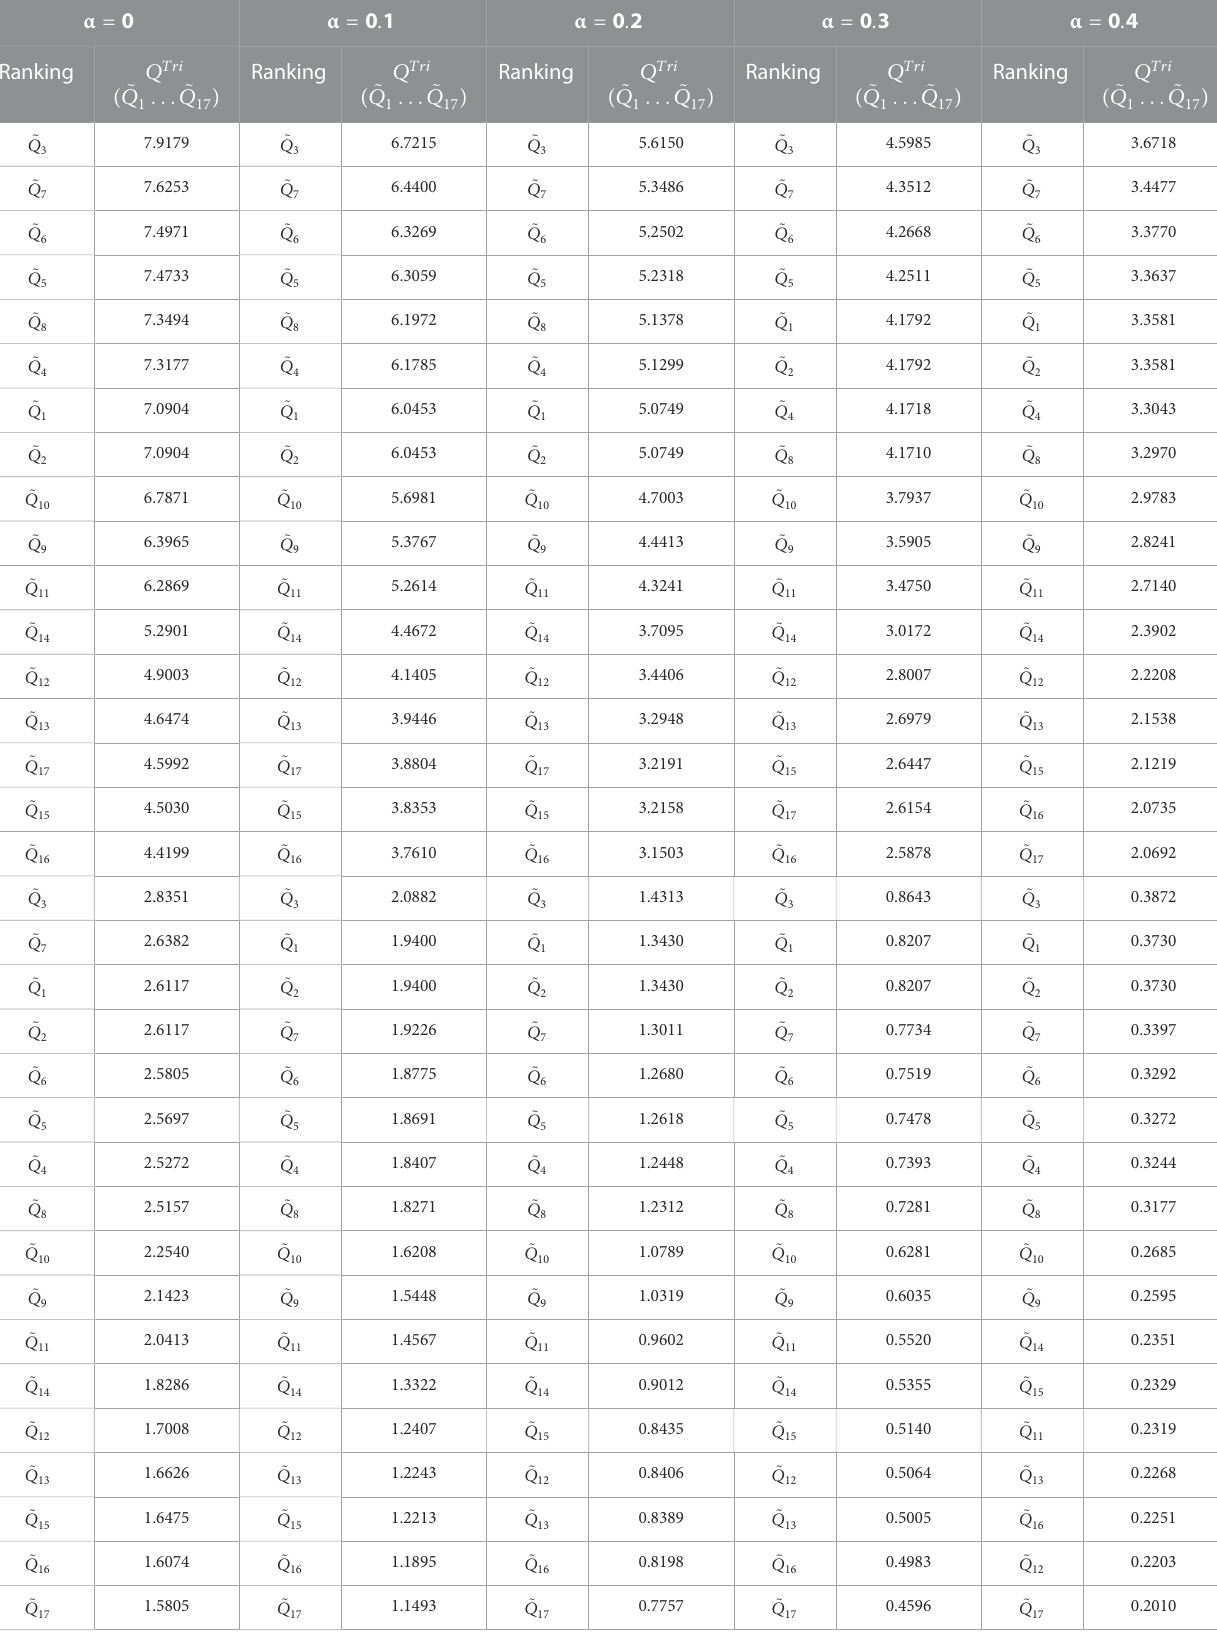
TABLE 5 The ranking of fuzzy ~ Q i values of alternatives according to different α -cut levels. α (cid:1)